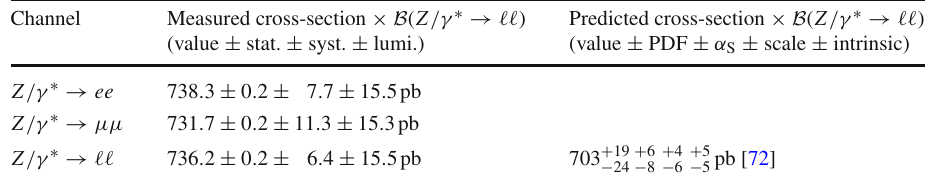
MCsamplesizes.The p (cid:3)(cid:3) distributionissplitintolinearandlogarithmic T > 200 scales at 30 GeV. Some uncertainties are larger than 2% for p (cid:3)(cid:3) T GeV and hence cannot be displayed. The corresponding uncertainties are also summarized in Table 4